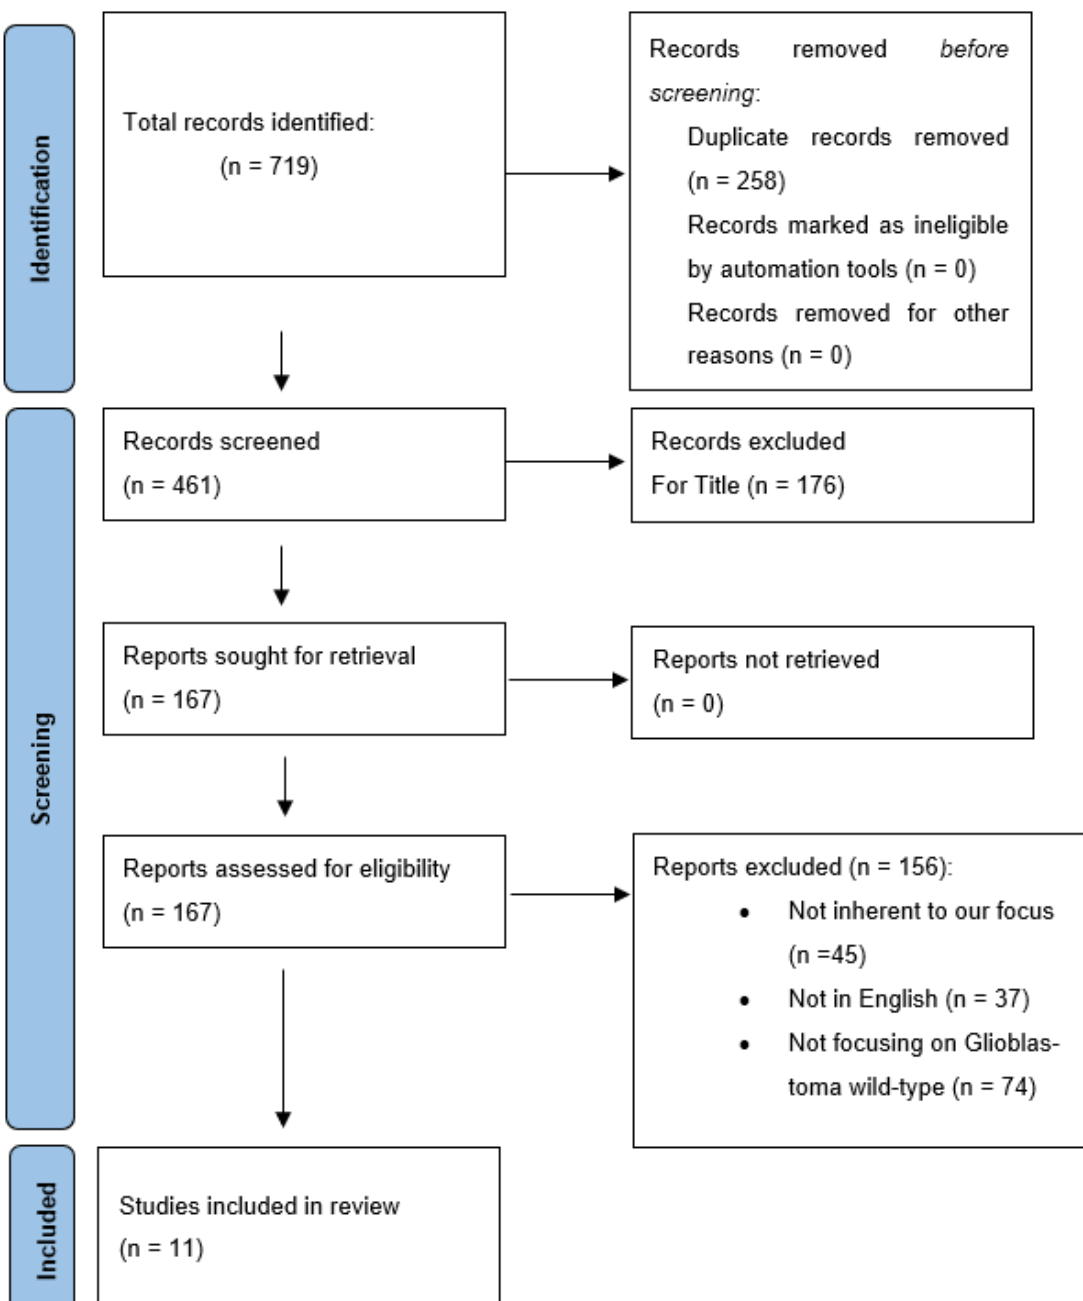
Figure 1. PRISMA flow chart of selection process.